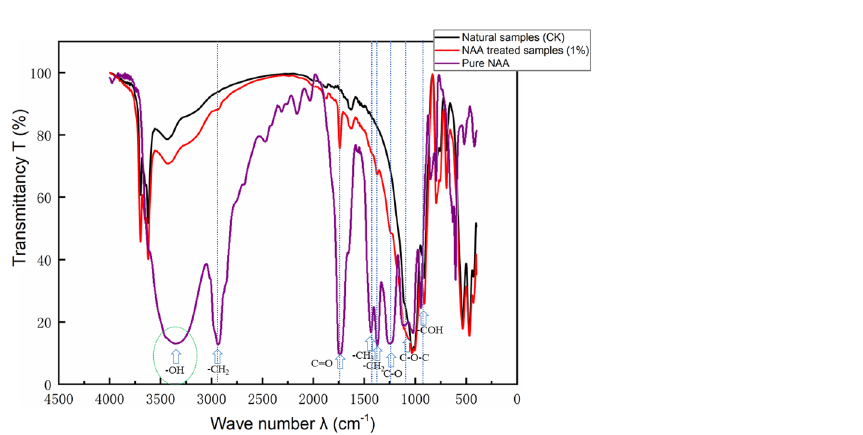
Figure 7. Results of infrared